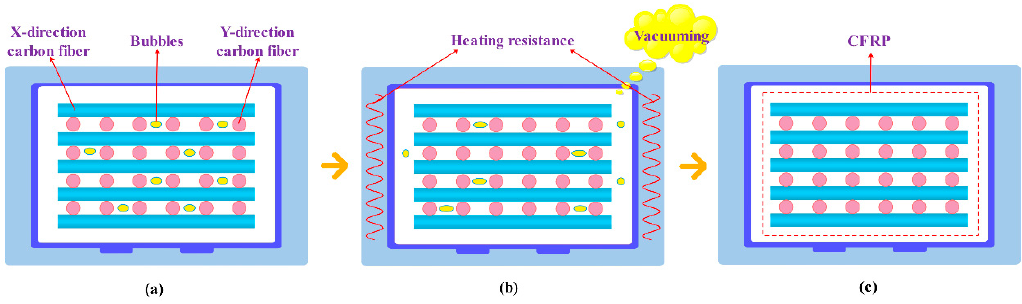
Figure 3. Schematic process of the vacuum heating infiltration module: ( a ) initial state; ( b ) intermediate state; ( c ) final state.